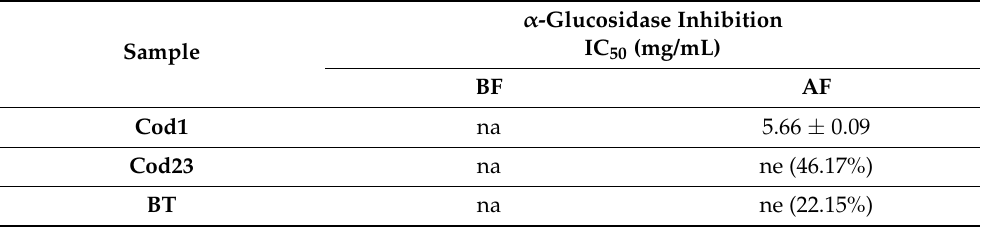
Table 2. Effect of kombucha fermentation on α -glucosidase inhibitory activity.